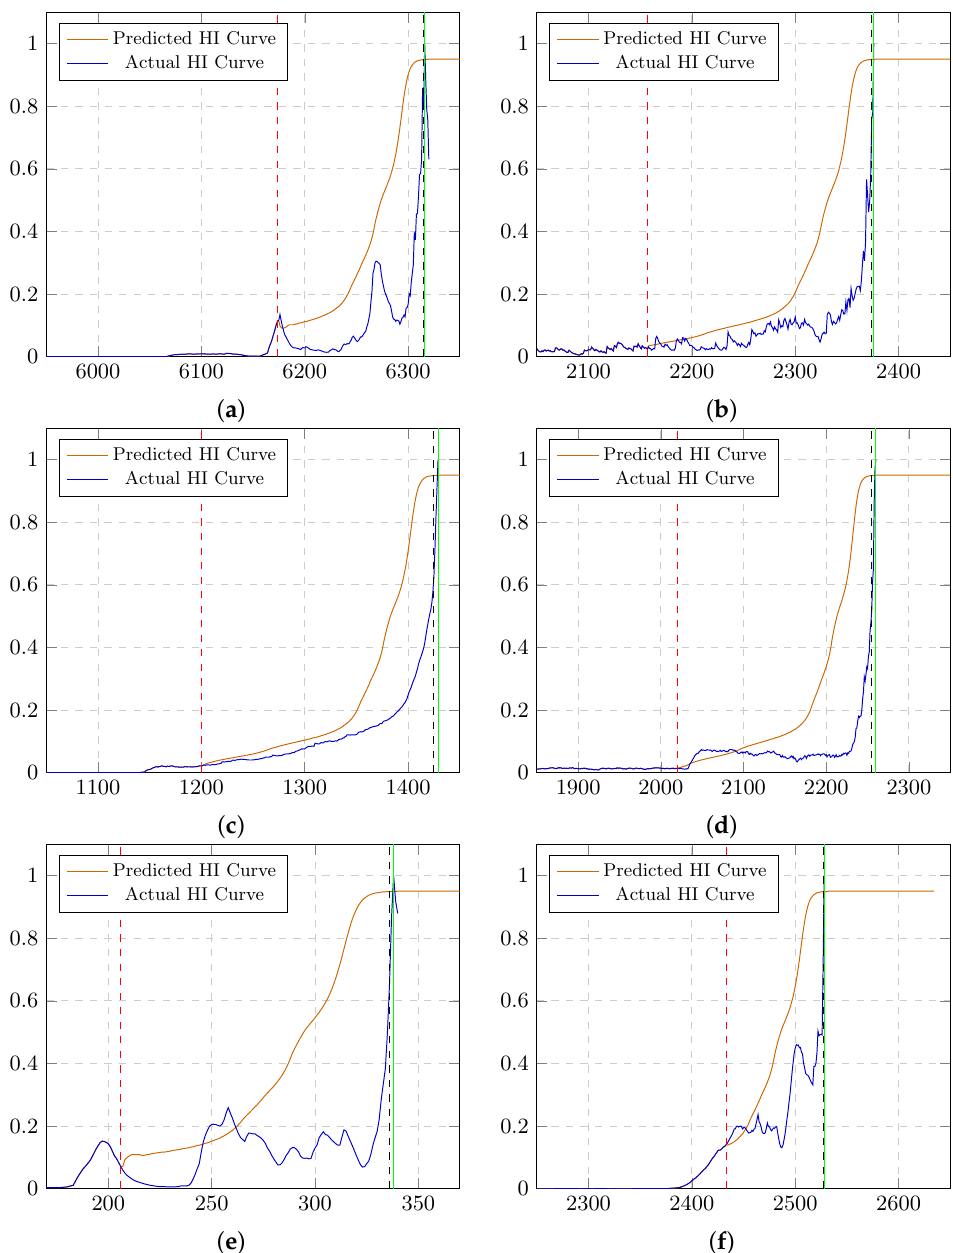
Figure 7. RUL prediction. ( a ) IMS dataset no. 3. ( b ) FEMTO Bearing1_3. ( c ) FEMTO Bearing1_4. ( d ) FEMTO Bearing1_7. ( e ) XJTU-SY Bearing2_5. ( f ) XJTU-SY